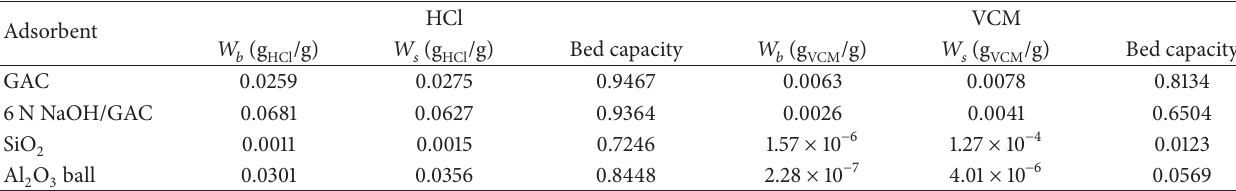
Table 3: HCl and VCM adsorption capacity over